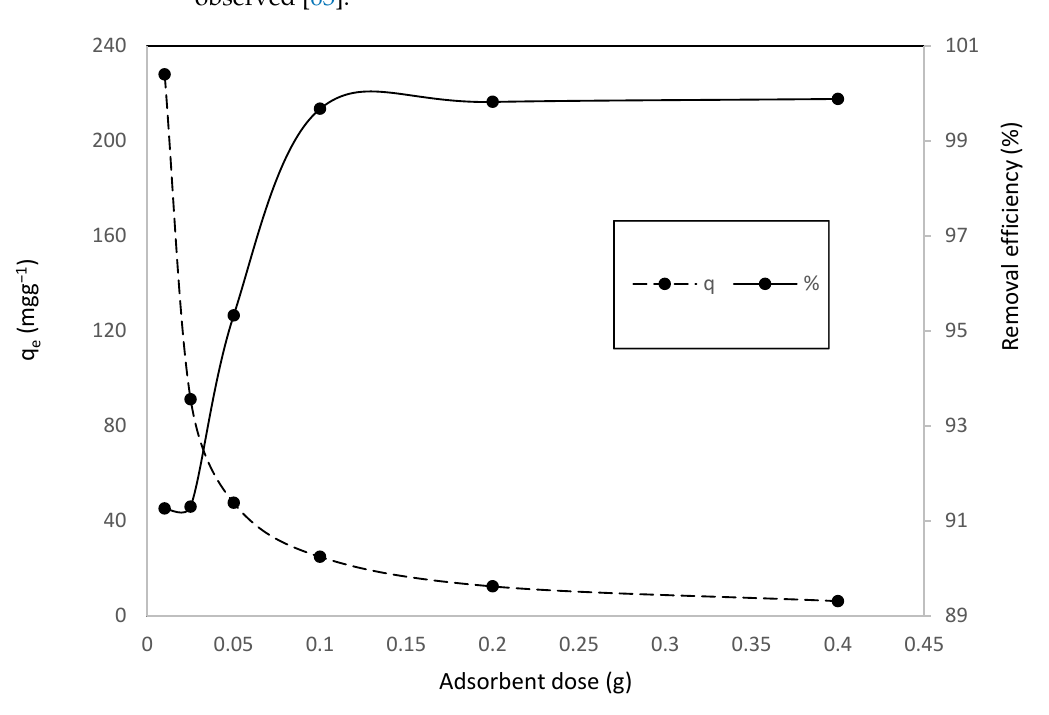
Figure 4. Effect of adsorbent dosage on adsorption of of MV onto HNC.